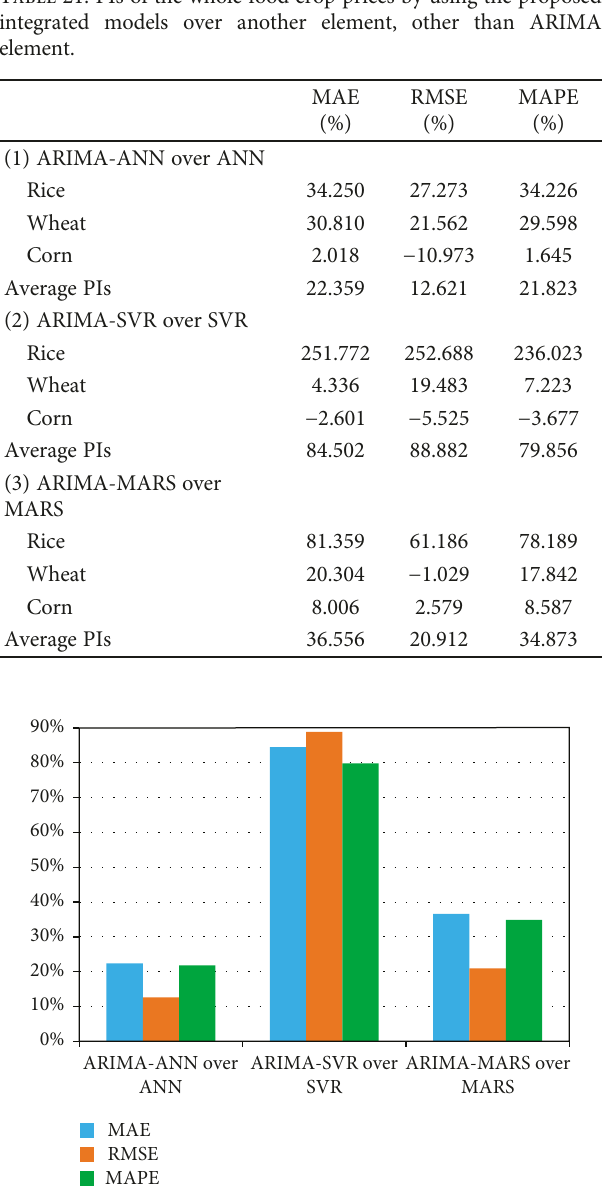
Table 21: PIs of the whole food crop prices by using the proposed integrated models over another element, other than ARIMA element.